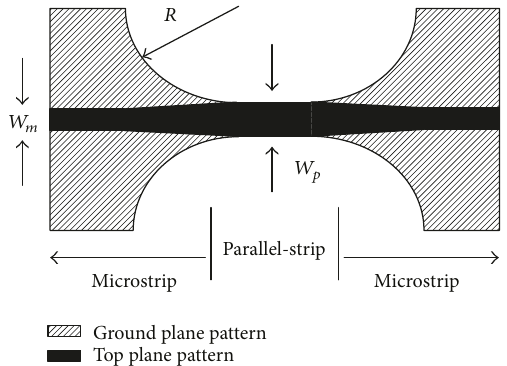
Figure 5: Circularly tapered conversion circuit.